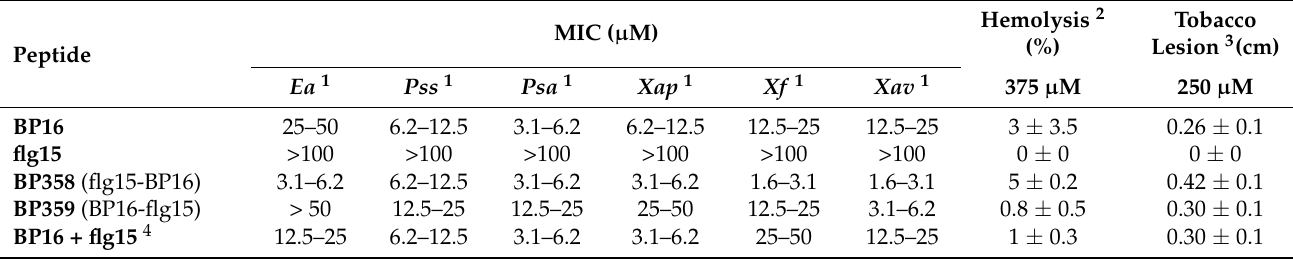
Table 2. Antimicrobial activity (MIC), hemolysis, and phytotoxicity of the peptides.